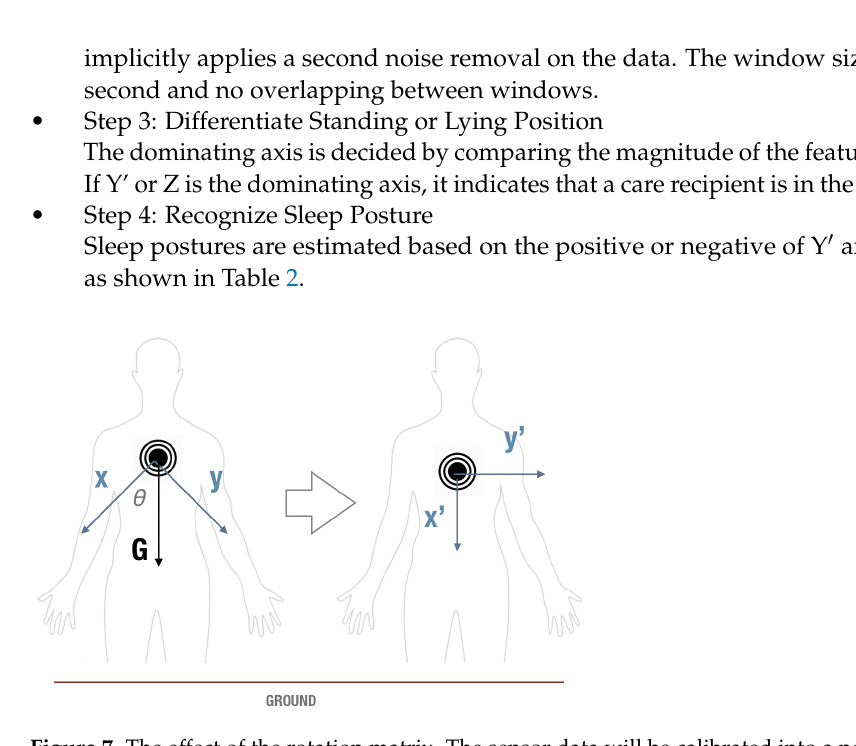
Figure 7. The effect of the rotation matrix. The sensor data will be calibrated into a new X axis which is perpendicular to the ground and a new Y axis which is parallel to the ground. Table 2. Decision